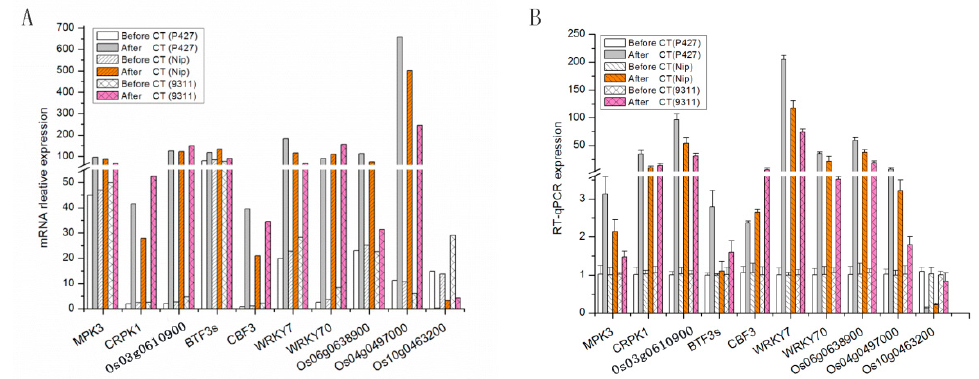
Figure 8. Comparison of gene expression levels using RNA-Seq and qRT-PCR. ( A ) Relative mRNA expression. ( B ) RT-qPCR expression. Relative expression values were normalized to the rice actin 1 gene. Error bars indicate the standard deviation.